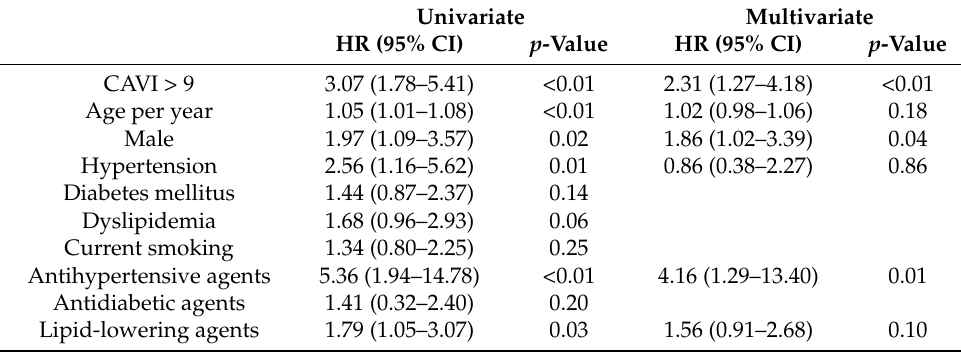
Table 2. Association Between the CAVI and Cardiovascular